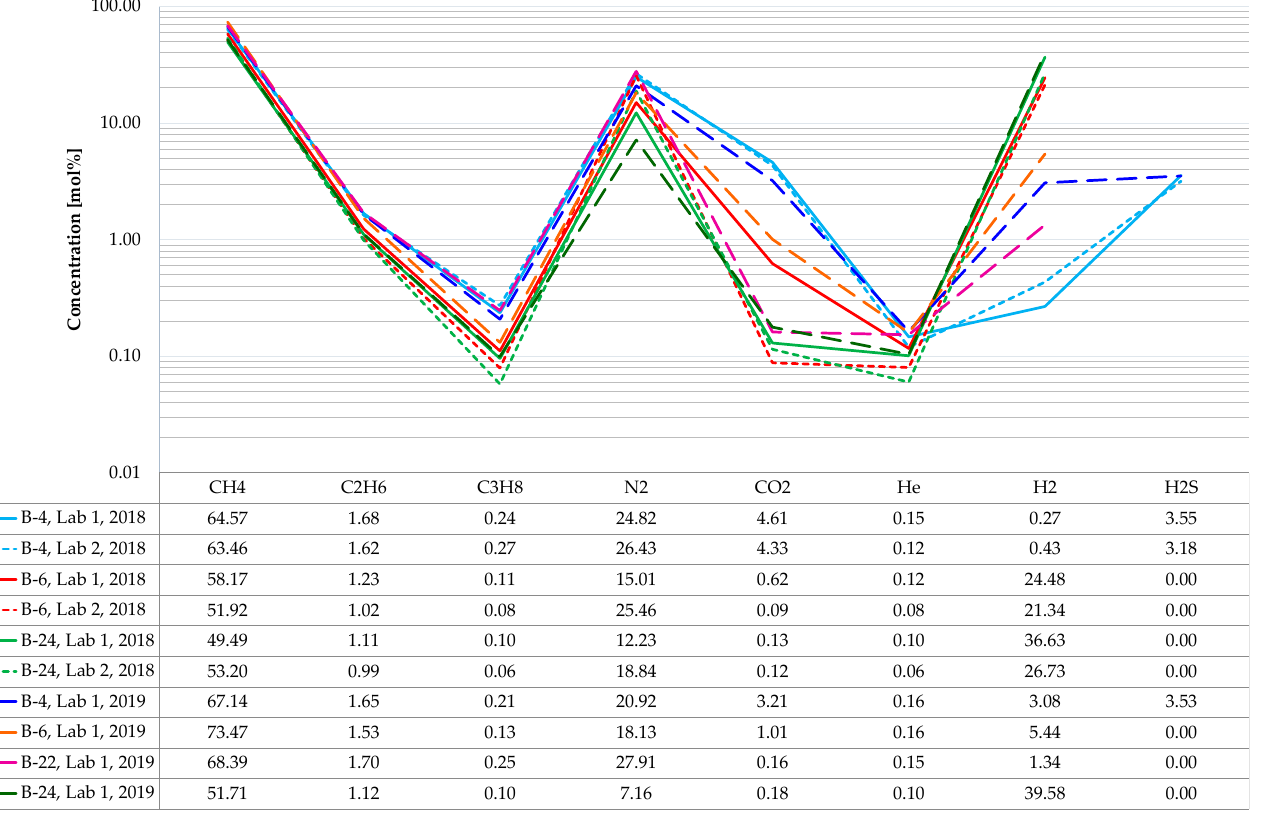
Figure 3. Composition of the gas dissolved in the Borz˛ecin reservoir water. It should be noted that from certain wells (B-4, B-6, B-24) samples were taken twice (in 2018 and 2019), and, in addition, a part of those samples were analysed in separate laboratories. Methane is the main hydrocarbon component of the gas released from the reservoir water, with an average content of approximately 60 mol% based on 10 analyses. The next are: ethane (1.4 mol%) and propane (0.16 mol%)—the other hydrocarbon com- ponents are negligible (below the significance level to the studied phenomena), and they were not included in the presented specification. The non-hydrocarbon components are dominated by nitrogen (approximately 20 mol%), followed by carbon dioxide (on average 1.5 mol%, but in samples originating from the B-4 well its amount is highest, reaching 4.6 mol%). Small amounts of helium (on average slightly more than 0.1 mol%) were also identified in each sample. Additionally, strongly varying hydrogen concentrations were determined in the studied gases. For two productive wells (B-4 and B-22), the values are relatively low, i.e., on average, approximately 1.3 mol%, while for the other wells, turned out from gas production, the hydrogen concentrations were much higher—on average 30 mol%. The highest hydrogen concentrations (reaching almost 40 mol%) were recorded in the B-24 well, which will be discussed hereafter. Hydrogen sulphide, on an average level of 3.4 mol%, was identified only in the gas samples from the B-4 well. To estimate the direction and intensity of acid gases migration, the CO 2 and H 2 S concentration in relation to the distance from the injection well was also analysed. Studies showed that water originating from the Borz˛ecin-4 well is saturated to the largest